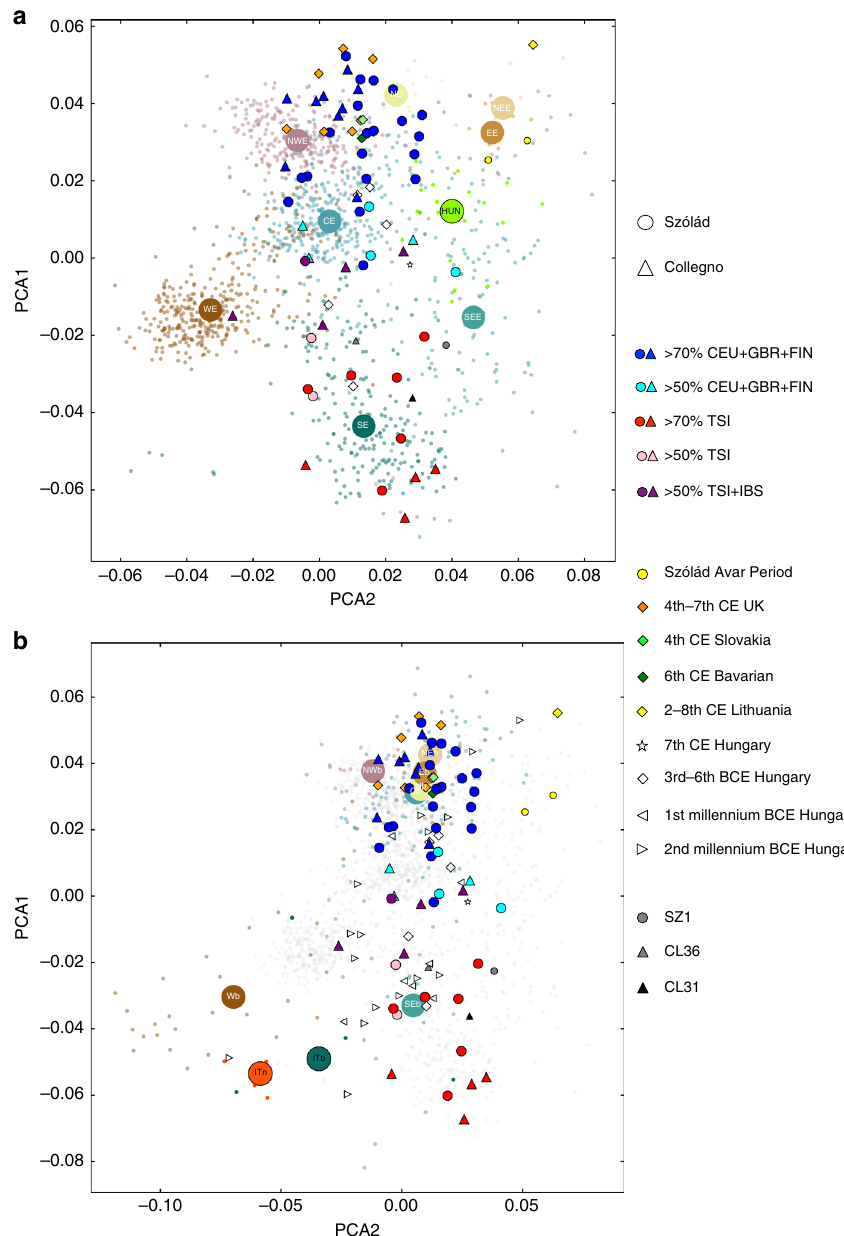
Fig. 2 Principal component analysis of Szólád and Collegno. a Procrustes PCA of modern Europeans (faded small dots are individuals, larger circle is median of individuals) along with samples from Szólád ( fi lled circles), Collegno ( fi lled triangles) and other Migration Period samples. Szólád and Collegno samples are fi lled with colors based on estimated ancestry from ADMIXTURE. NWE, modern northwest Europe; NE, modern northern Europe; NEE, modern northeast Europe; CE, modern central Europe; EE, modern eastern Europe; WE, modern western Europe; SE, modern southern Europe; SEE, modern southeast Europe; HUN, modern Hungarian. b Procrustes PCA of modern and Bronze Age Europeans along with samples from Szólád and Collegno and other Migration Period samples. Gray dots are modern Europeans as shown in a . NWb, Bronze Age northwest Europe; Nb, Bronze Age northern Europe; NEb, Bronze Age northeast Europe; Cb, Bronze Age Europe; Eb, Bronze Age Europe; Wb, Bronze Age western Europe; SEb, Bronze Age southeast